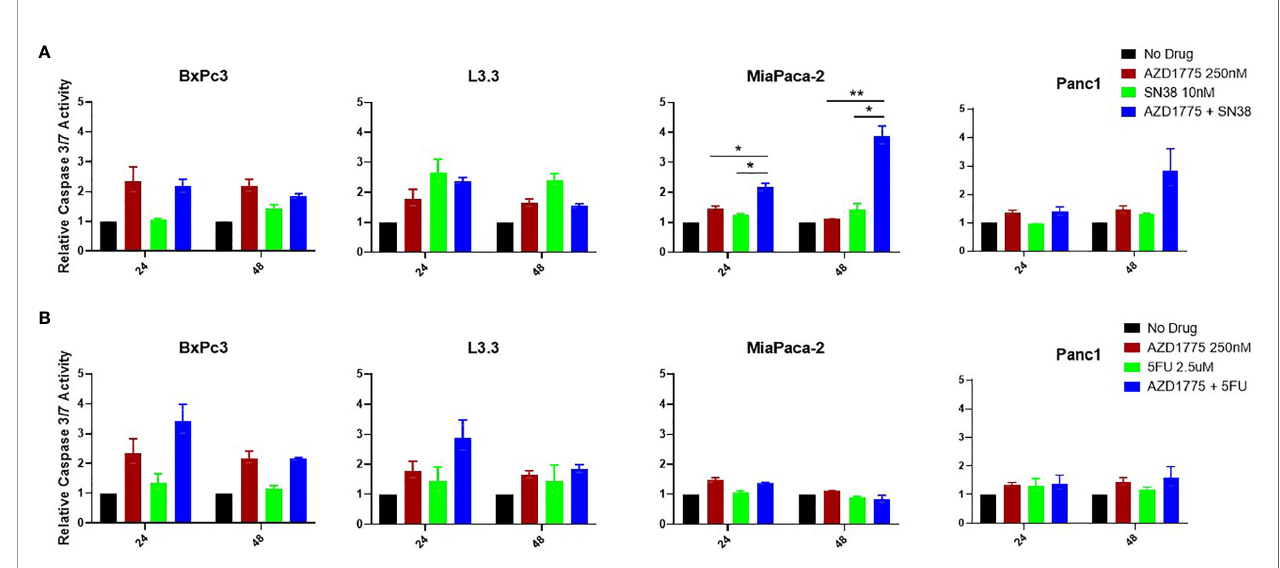
FIGURE 4 | Apoptotic effects of AZD1775 (250 nM) and (A) SN38 or (B) 5-FU in PDAC cell lines. Cells were treated with AZD1775 and SN38 or 5-FU for 24 and 48 hours, and apoptosis was measured using a Caspase Glo 3/7 assay with data normalized to the No Drug control. Data were analyzed with a t-test to compare